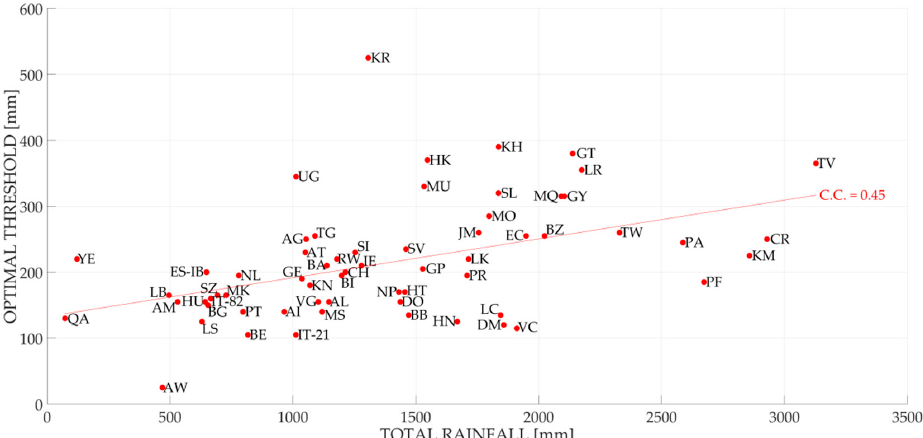
Figure 7. The optimal thresholds for every country object of study obtained using a false alarm cost equal to 1 and a missed alarm cost equal to 5 compared to the total rainfall of the country: The results refer to a 24-h aggregation interval. The countries naming follow ISO 3166.